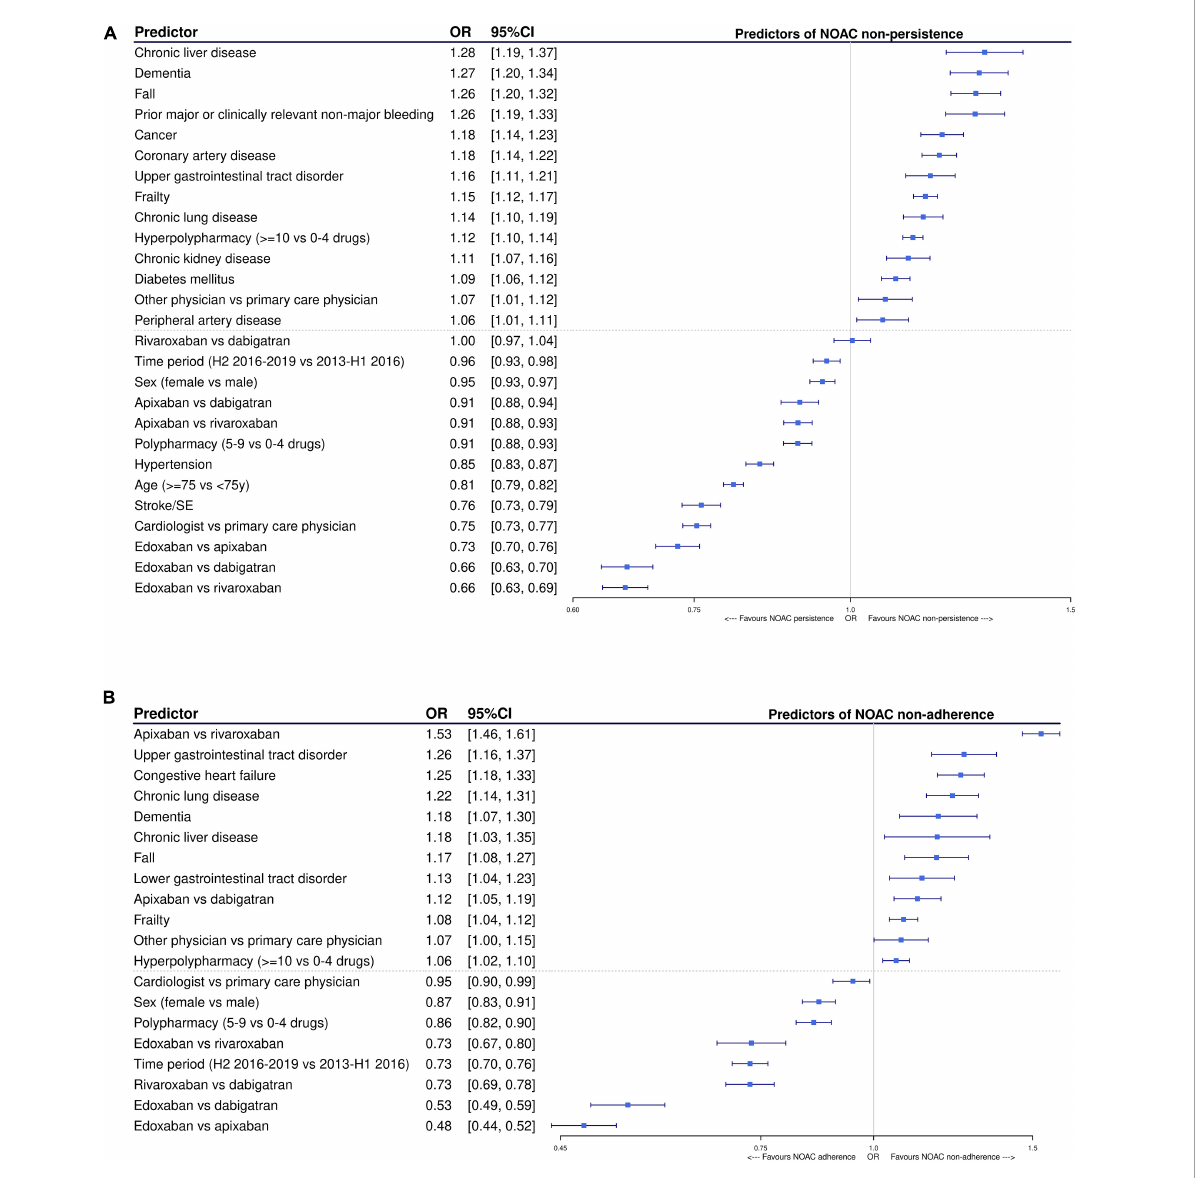
FIGURE6 Factors significantly associated with being (A) non-persistent and (B) non-adherent (PDC < 90%) after 1 year of follow-up in NOAC-treated AF patients after multivariable adjustment, using multivariable logistic regression with backward elimination. Only statistically significant factors were retained in the final model. AF, atrial fibrillation; CI, confidence interval; H1/H2, first/second half-year; NOAC, non-vitamin K antagonist oral anticoagulant; OAC, oral anticoagulant; OR, odds ratio; PDC, proportion of days covered; SE, systemic embolism; VKA, vitamin K antagonist; vs., versus; y,